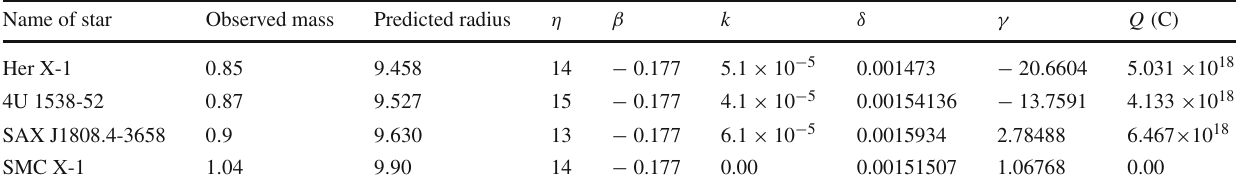
Table 1 Values of constants of charge stars for α = − 2 . 3 by choosing different values of k , β , and η , where k = 0 for neutral star Name of